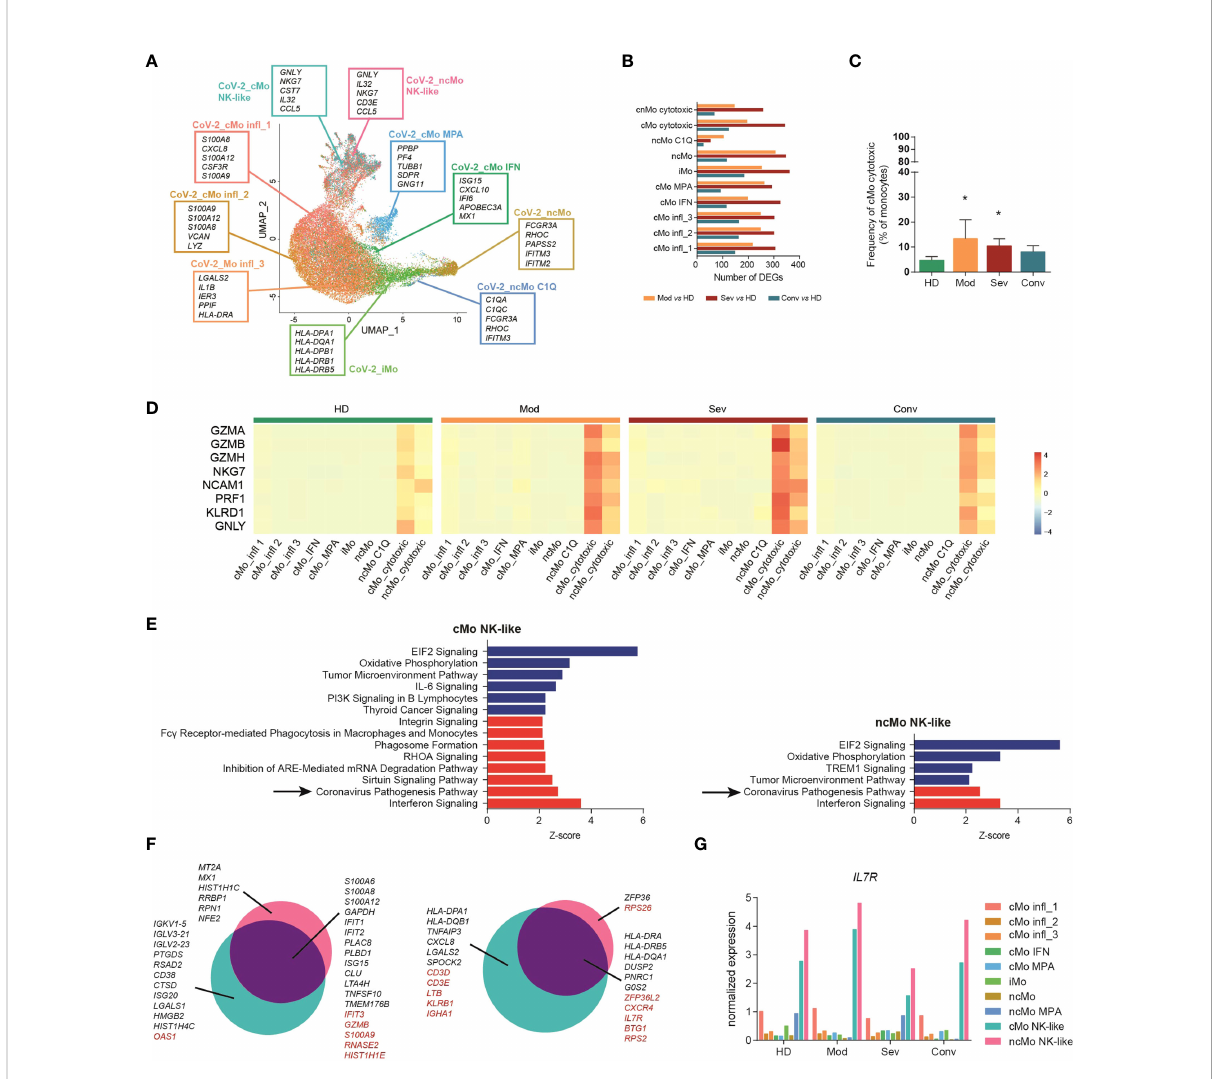
FIGURE 5 Cytotoxic monocytes are involved in COVID-19. (A) UMAP projection of Cov-2 pts monocytes clustered using the machine learning classi fi er. Up to fi ve cluster marker genes are listed in boxes next to each cluster. Cluster marker genes are de fi ned as in Material and Methods. (B) Bar plot showing the number of DEGs between monocytes from COVID-19 patients with different pathological conditions and healthy donors. (C) Percentage of cMo cytotoxic over the total monocyte population from healthy donors and Cov-2 pts. Statistical signi fi cance was determined by the Dunn ’ s multiple comparisons test. (*) P < 0.05. (D) Heatmap showing the expression of selected cytotoxic genes in healthy donors (HD), patients with severe (sev) or moderate (mod) COVID-19 and convalescent patients with COVID-19 (conv). Gene expression is colored-coded from blue (lower) to red (higher); gene expression level is scaled by row. (E) Ingenuity pathway analysis of the DEGs between cytotoxic monocytes from severe COVID-19 pts and healthy donors. Only pathways that were signi fi cantly (-log10(p-val) > 1.3) upregulated (z score > 2, in red) or downregulated (z score < -2, in blue) are shown. Analysis of the other monocyte clusters are shown in Figure S7 (F) Venn diagram showing the distribution of DEGs in cytotoxic monocytes between moderate and severe patients. Genes in black are differentially expressed also in other monocyte subpopulations; genes in red are differentially expressed exclusively in cytotoxic monocytes. (G) Bar plot showing the expression of IL7R in each cell cluster of the CoV-2 dataset. HD, healthy donors; sev, severe COVID-19 patients; mod, moderate COVID-19 patients; conv, convalescent